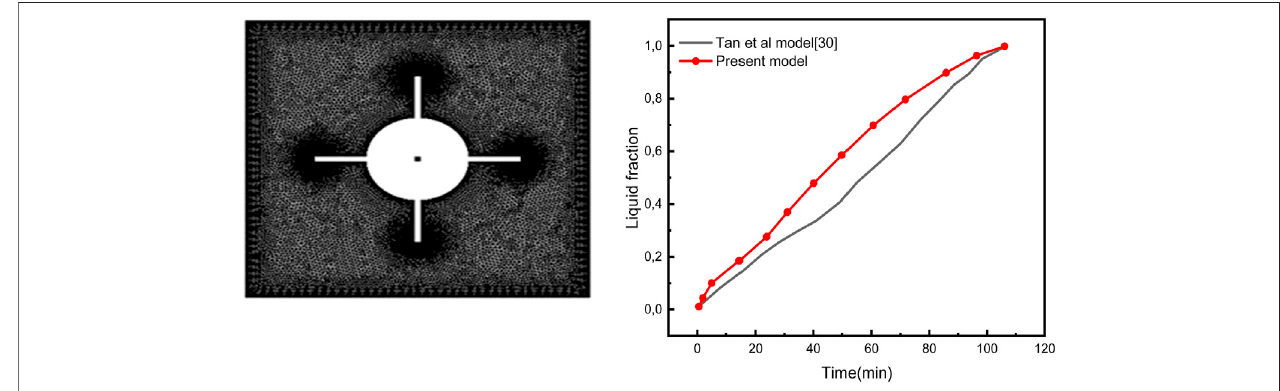
FIGURE 3 | Mesh grid and present model in comparison with [30].